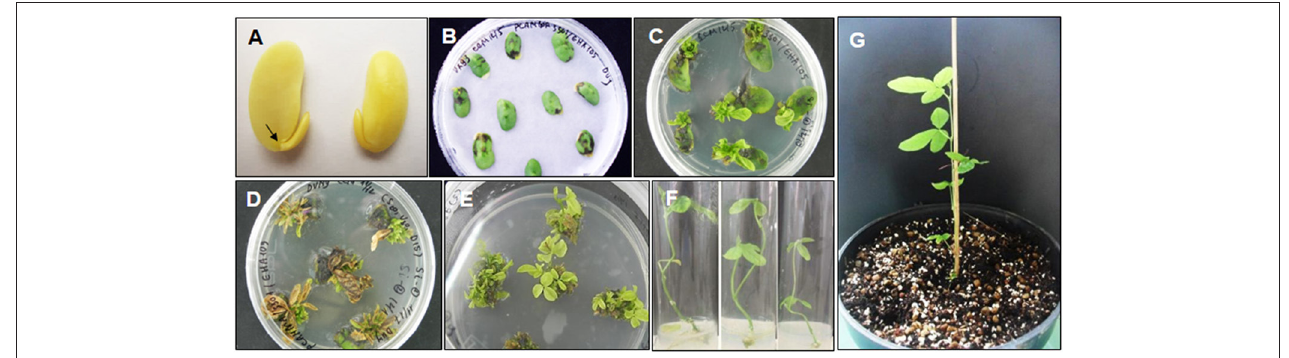
FIGURE 1 | VX93 soybean transformation bearded bar and cry1Ac -M#2 genes. (A) Half seed inoculated Agrobacterium tumefaciens on CCM medium with Whatman filter paper 3MM, (B) Shoots induction on SIM media, (C) The first selection shoots transgenic in SEM medium with phosphinothricin (PPT) 10mg L − 1 , (D) The